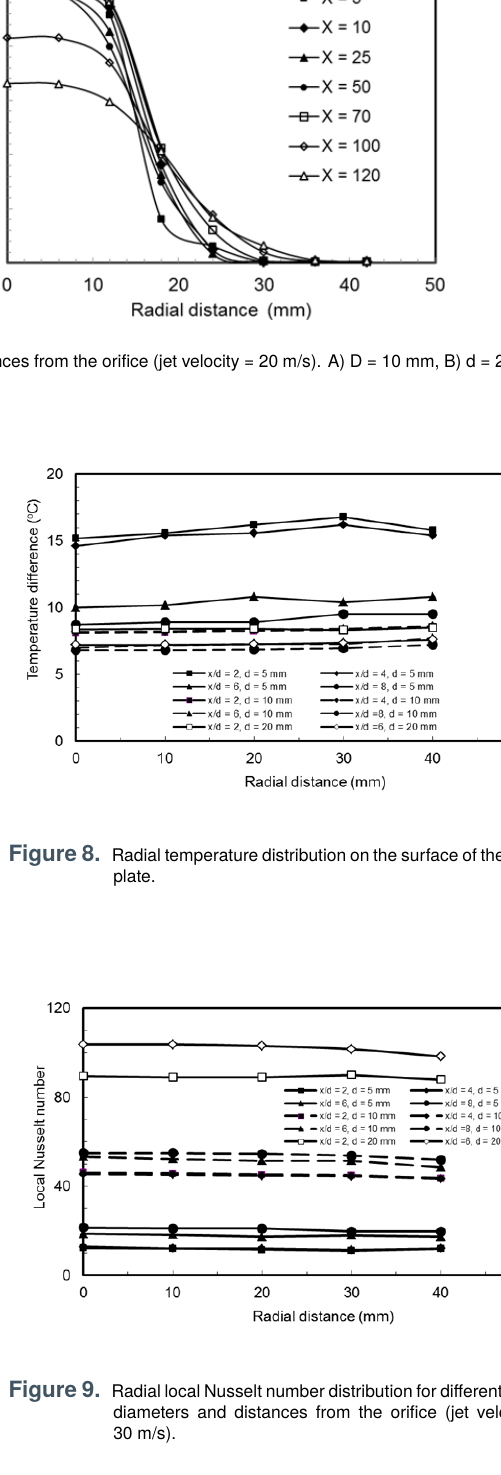
Figure 9. RadiallocalNusseltnumberdistributionfordifferentorifice diameters and distances from the orifice (jet velocity = 30